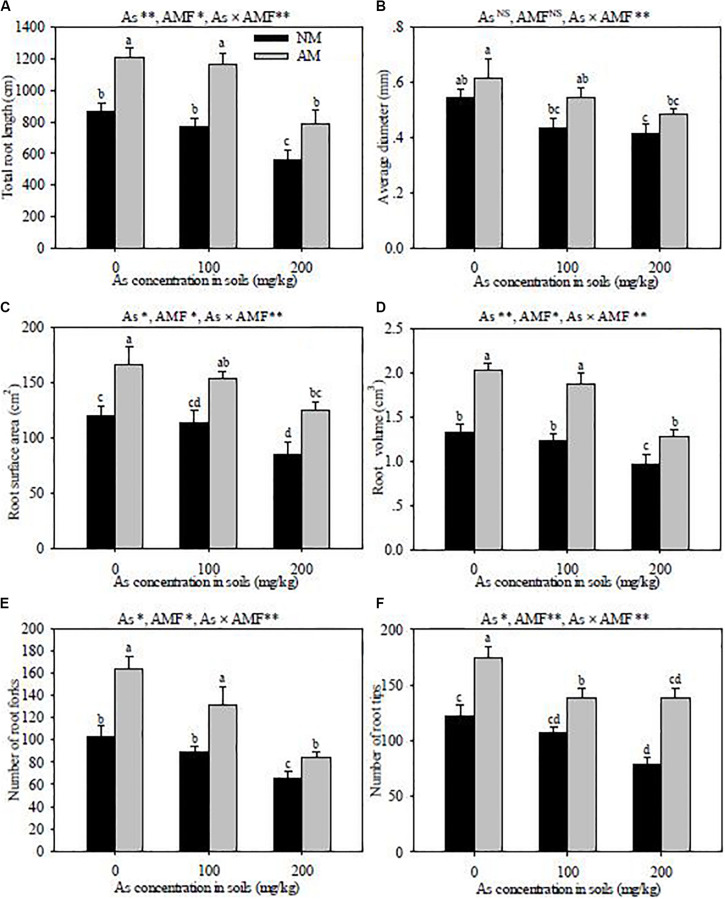
Effects of Rhizoglomus intraradices on total root length (A), root average diameter (B), root surface area (C), root volume (D), root fork number (E), and root tip number (F) in Robinia pseudoacacia seedlings under three different levels of As stress. Different letters indicate significant differences (P < 0.05) using Tukey’s test. Data are presented as the mean ± SD (n = 3). NS, not significant; As, arsenic addition levels; AMF, arbuscular mycorrhizal fungi inoculation; As×AMF, significant interactive effects of As level×R. intraradices. *P < 0.05; **P < 0.01.